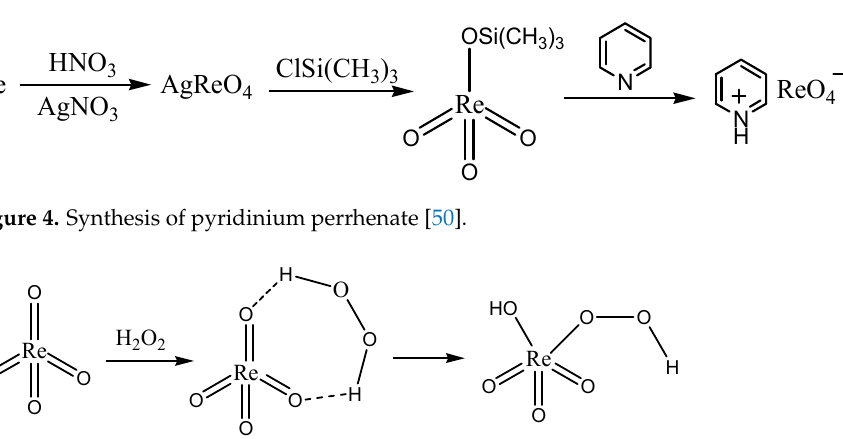
Figure 5. Interaction between Re and hydrogen peroxide [50]. Table 4. Catalytic performances of Sn-containing materials for the oxidation of cycloketones.